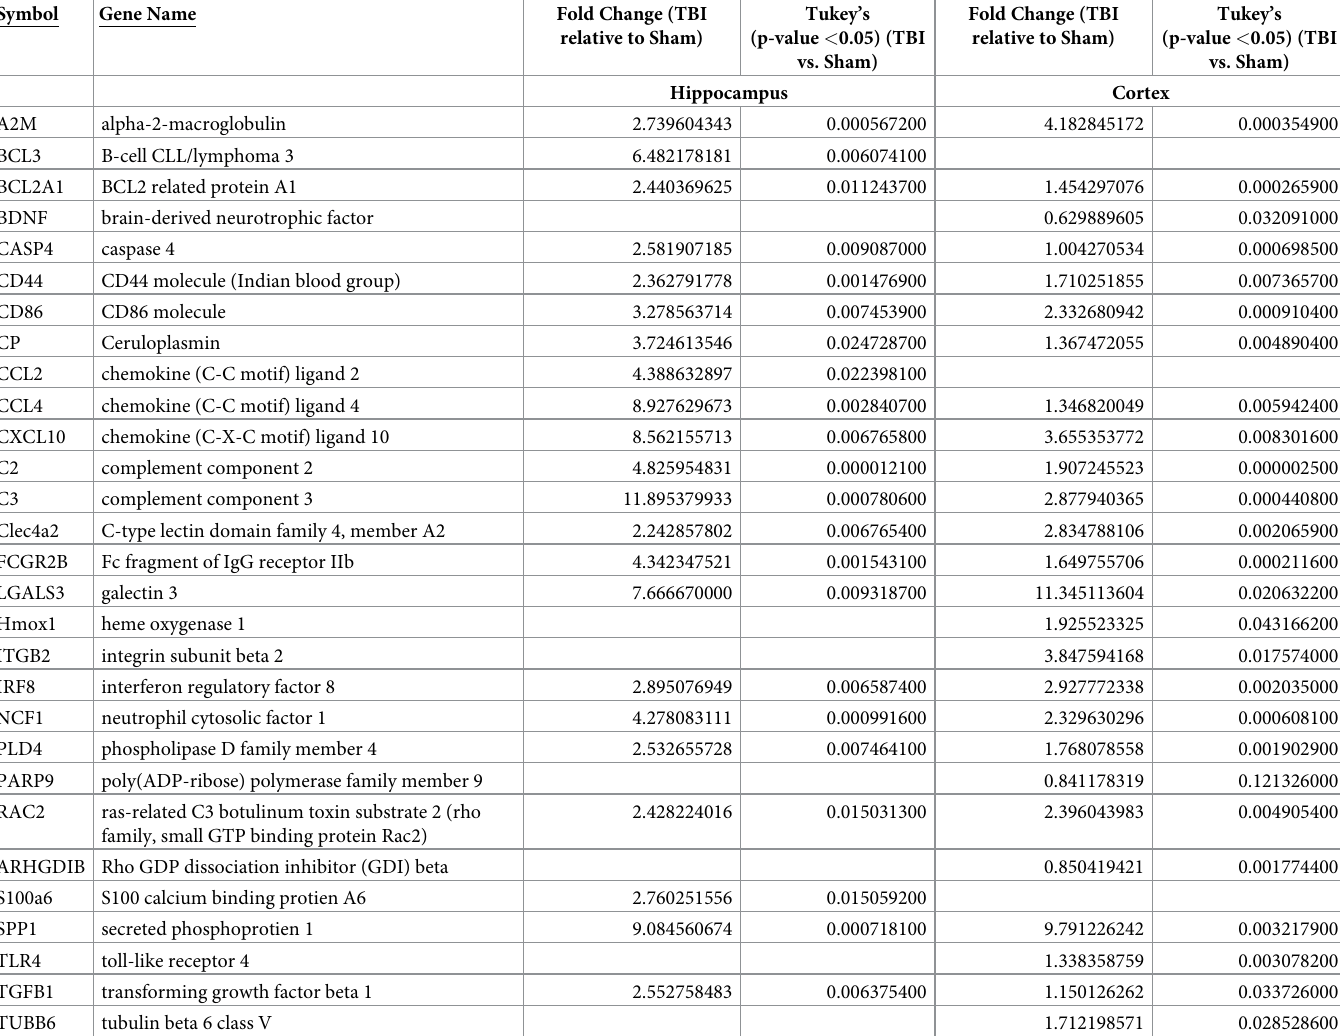
Table 1. Custom PCR array analysis of significant gene expression changes in hippocampus and cortex one month